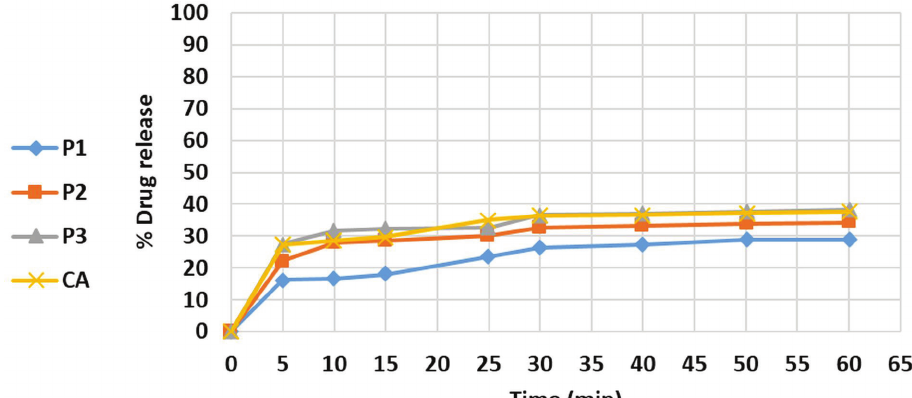
FIGURE 2 - In vitro dissolution profiles of cefuroxime axetil and physical mixtures.